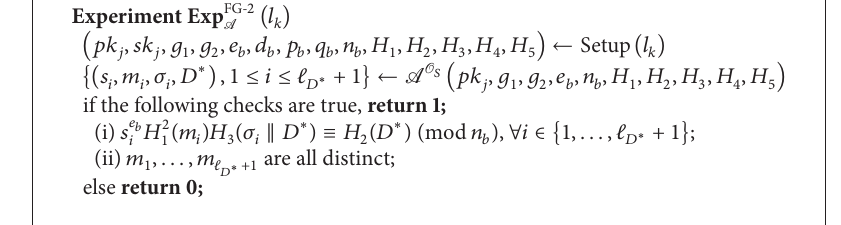
Algorithm 2: Experiment